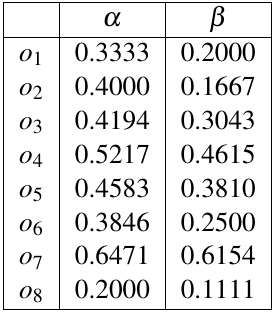
Table 2. Values of α and β for eight types of